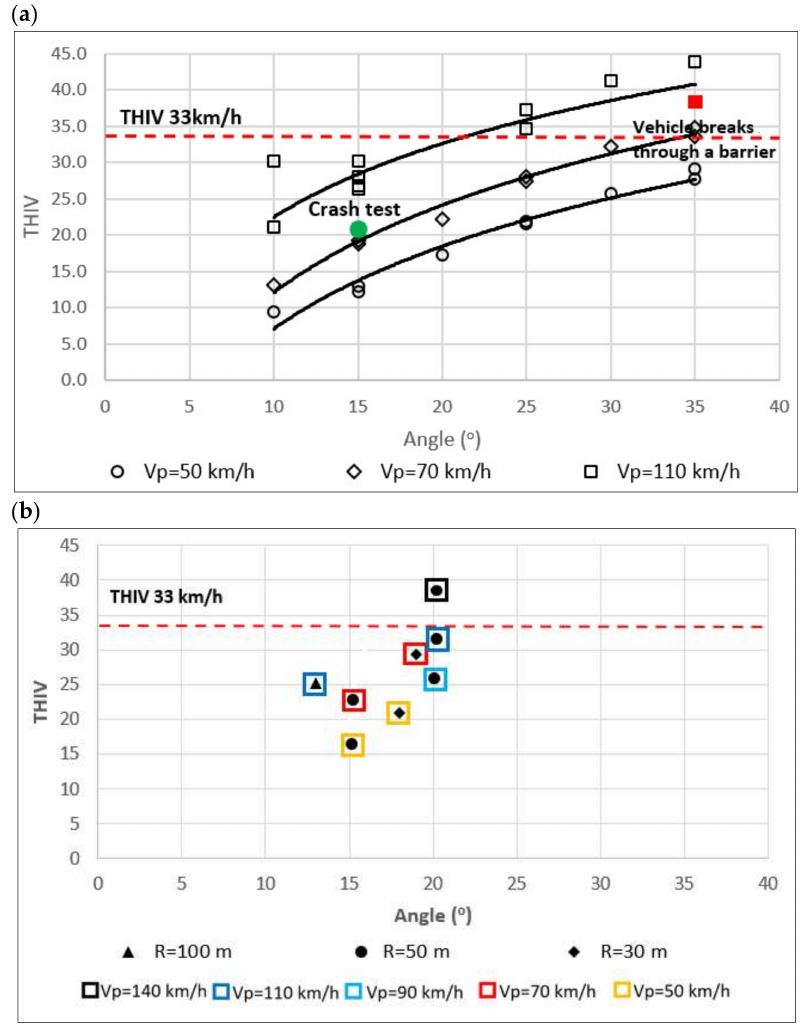
Figure 15. THIV rates achieved in numerical simulations of a vehicle impacting: ( a ) the SE’s beam, ( b ) a safety barrier behind an